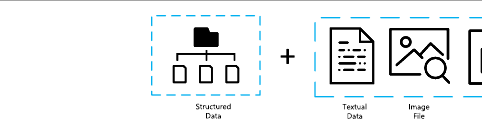
Fig. 4 Main categories of data variety in Big Data